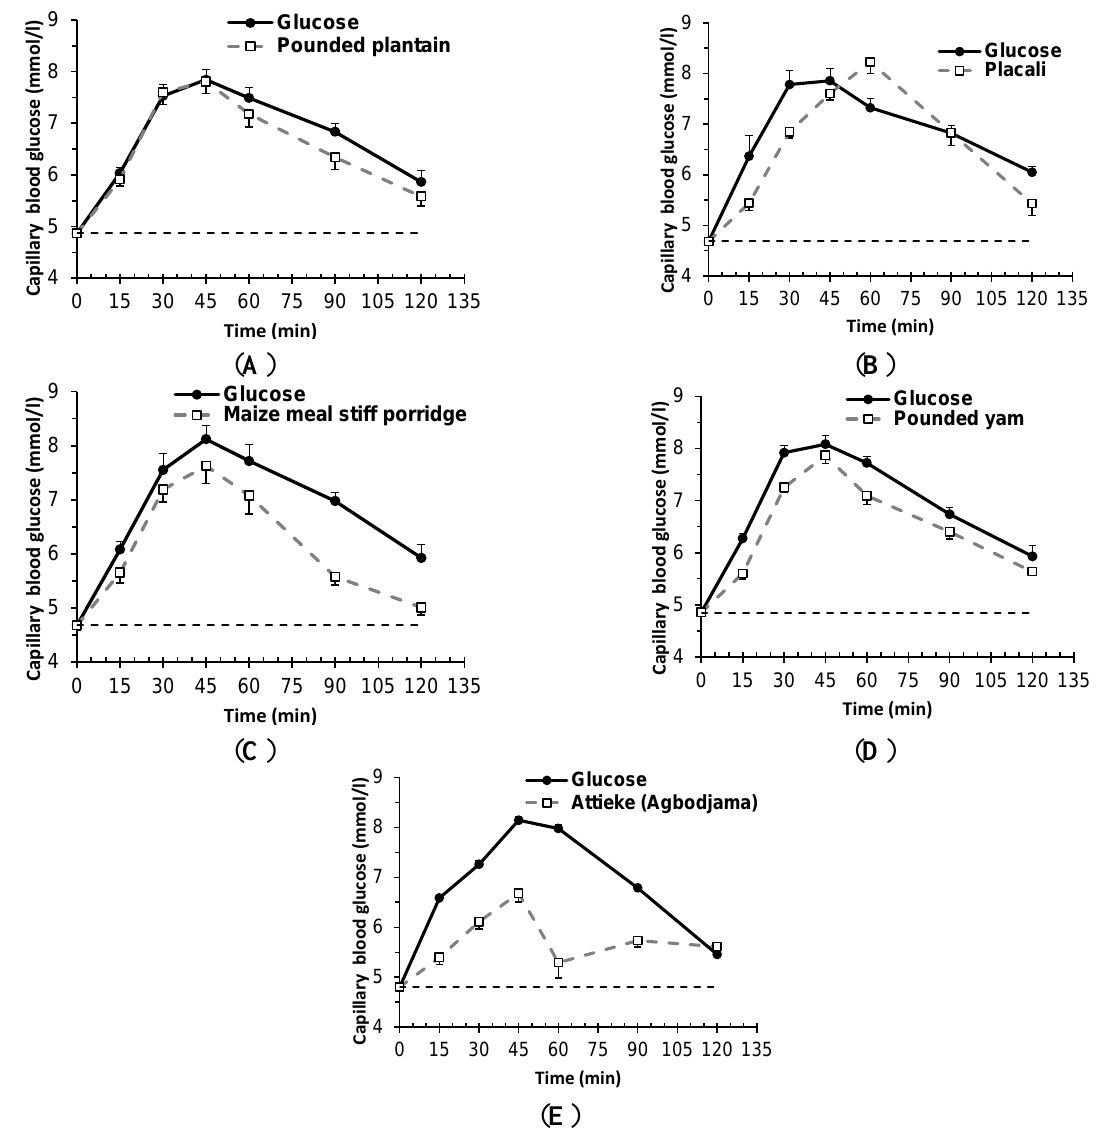
Figure 1. Graphs showing mean blood glucose concentrations for five traditional food product of Côte d’Ivoire (□ ( A ) Pounded plantain (pounded cassava-plantain), ( B ) placali, ( C ) maize meal stiff porridge (cabatôh), ( D ) pounded yam (foutou d’igname), ( E ) attieke); ● glucose). Values are the mean change in blood glucose (BG) with their standard deviation represented by vertical bars ( n = 10 persons per